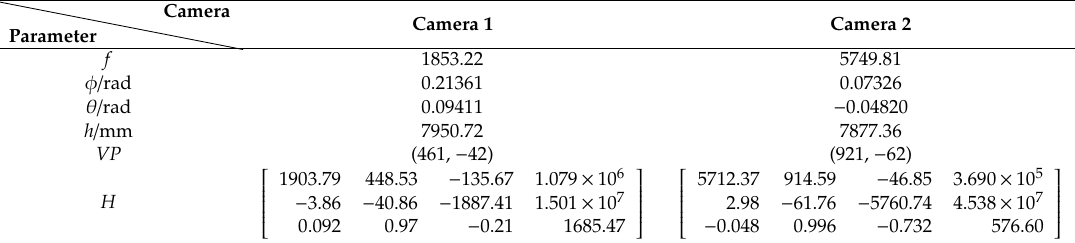
Table 6. Camera calibration results of actual road scene.